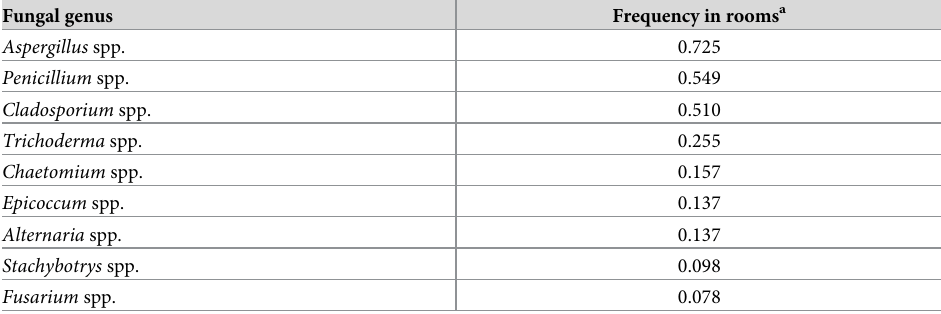
Table 3. Fungal community